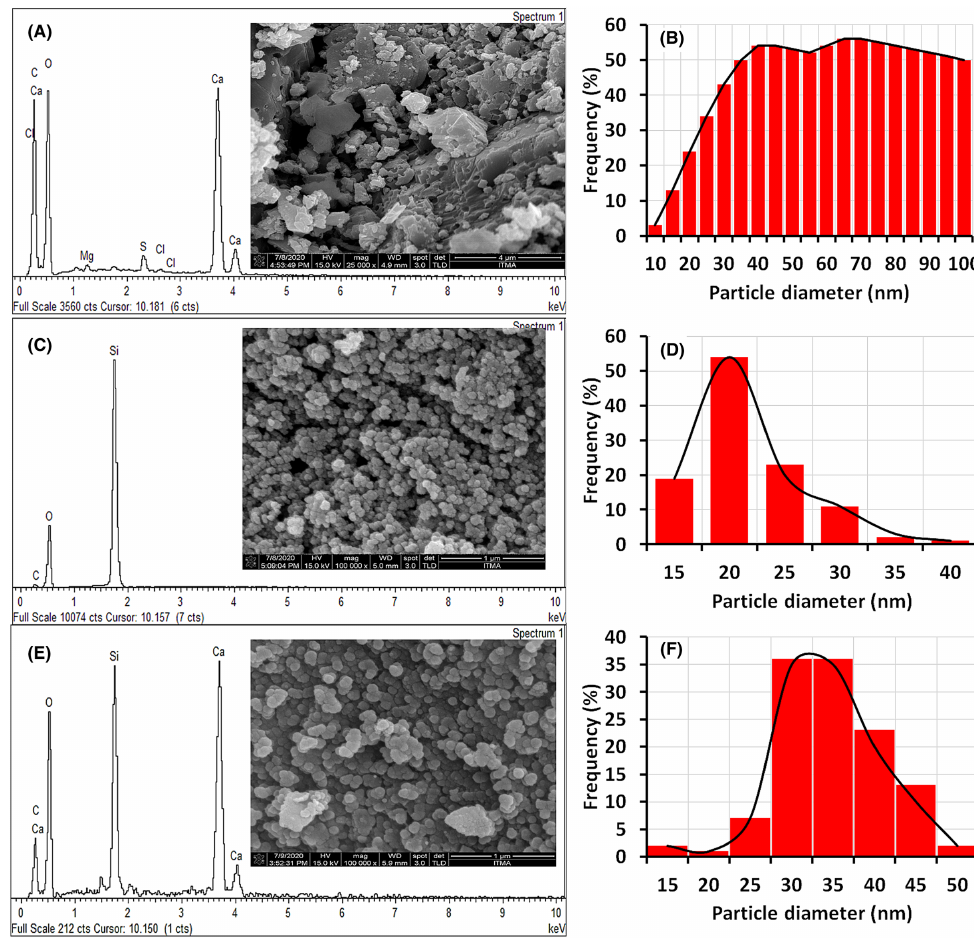
Figure 3 FESEM macrograph and EDX spectra of (A) ESCaCO 3, (C) RHSiO 2, (E) CS – SiO 2 /CaCO 3 nanocomposite and their corresponding particle size (B, D and